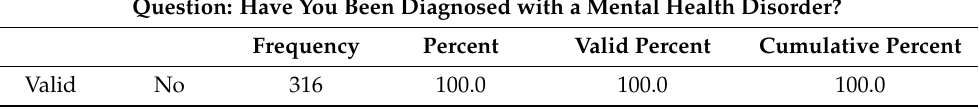
Table 4. Frequency table for mental health